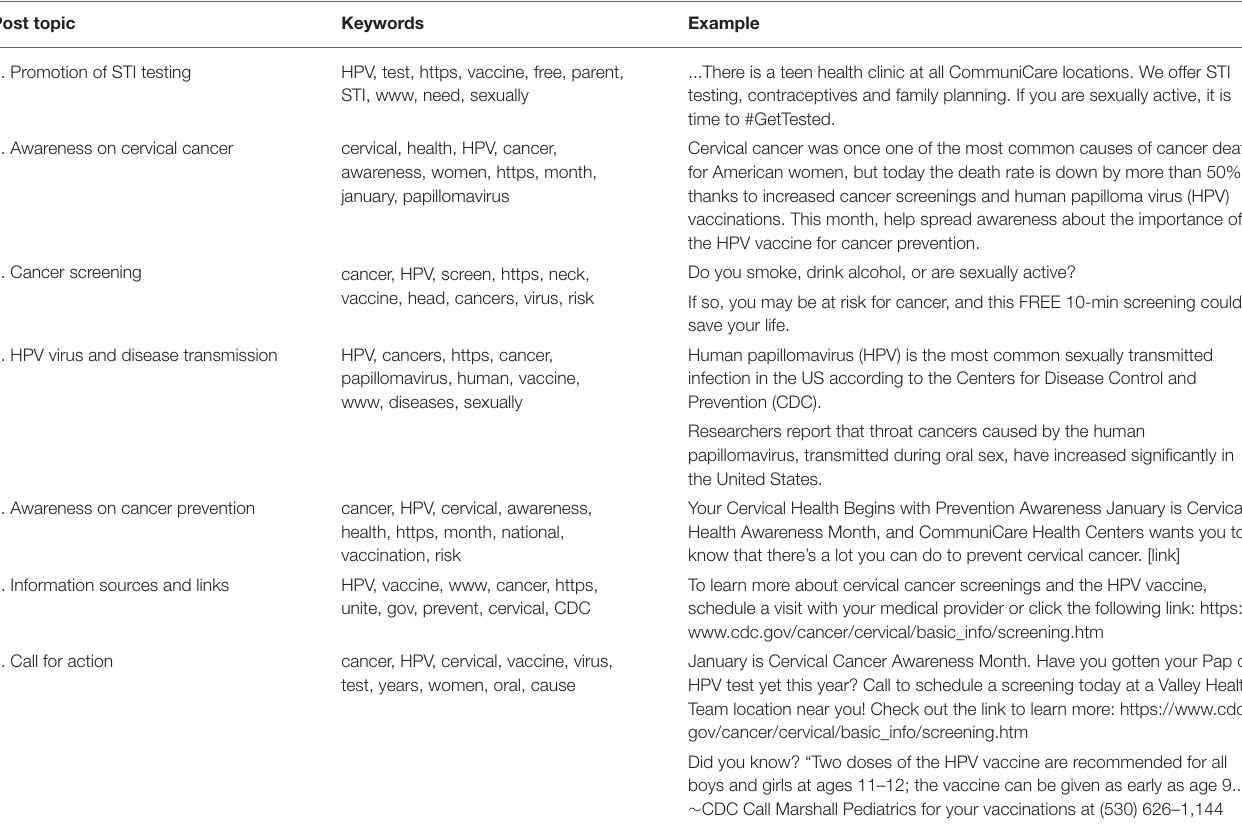
TABLE 4 | Thematic topics, keywords, and example Facebook posts about the HPV